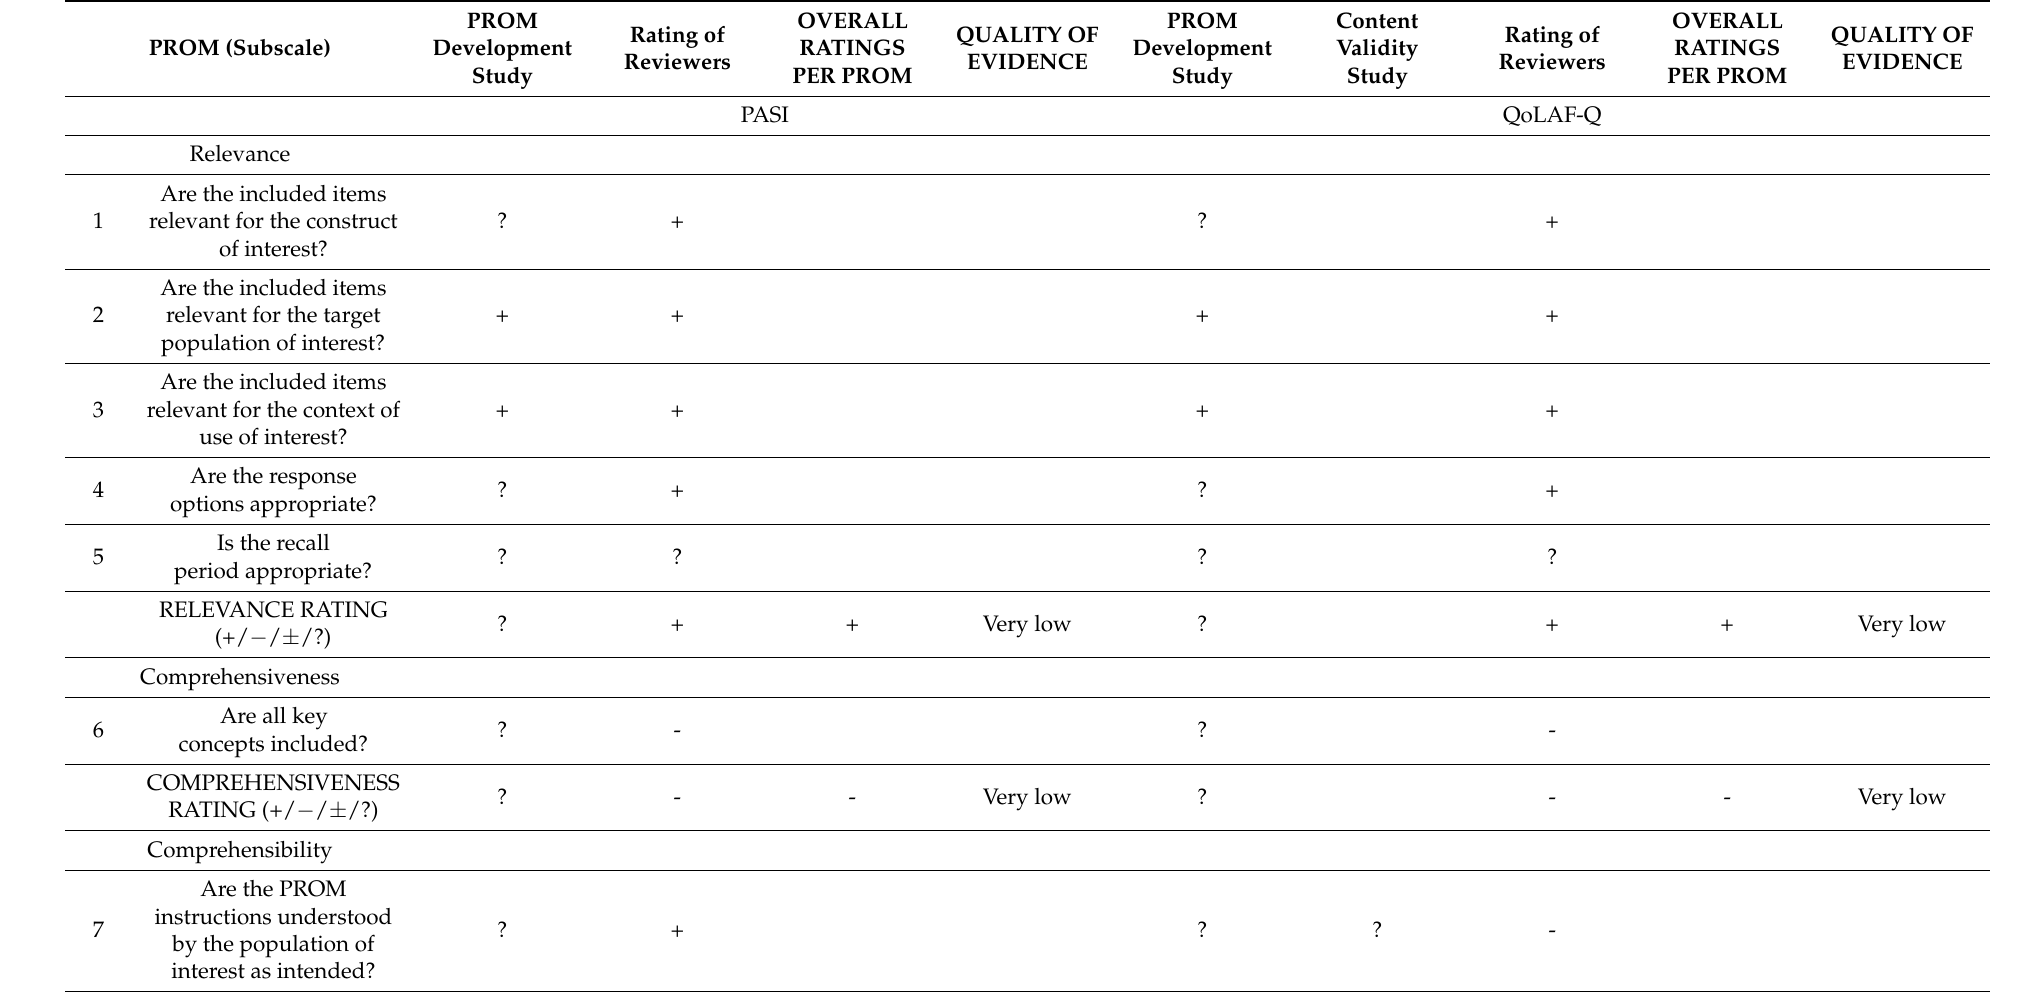
Table 3. Overall ratings for content validity and quality of